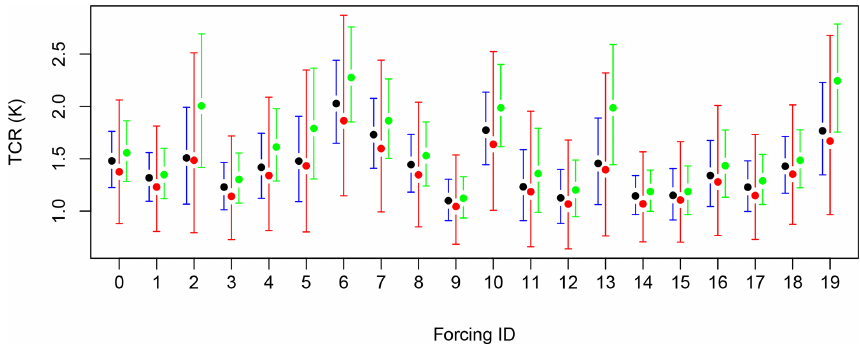
Figure 9. The posterior mean estimates and 95% credible intervals of the historical TCR for all forcing datasets using a scale-invariant (blue), a single-exponential (red), and a two-exponential (green) response function. ID number 0 denotes the Hansen forcing.